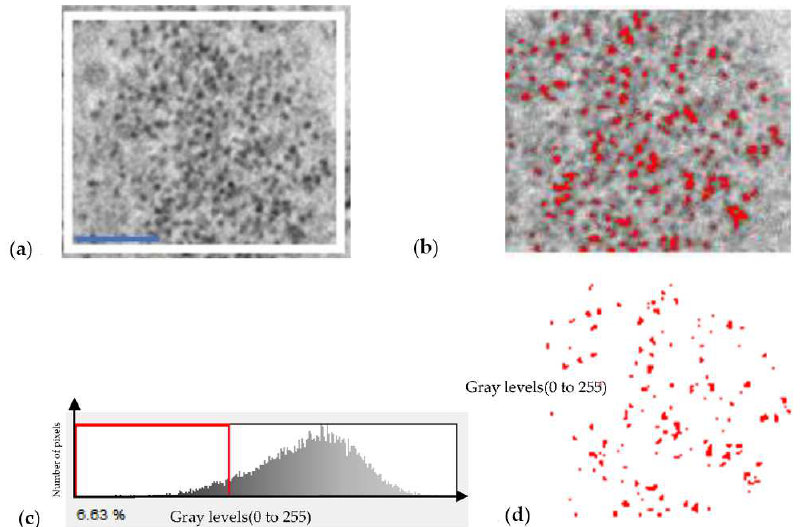
Figure 2. The white rectangle region from the background extracted from Figure 1. ( a ) The original image with a scale bar of 100 nm. ( b ) Image after selection of the SPIO nanoparticles in red color, ( c ) SPIOs were extracted from ( b ) using threshold method, and ( d ) is the threshold selected at the first minimum of the histogram.